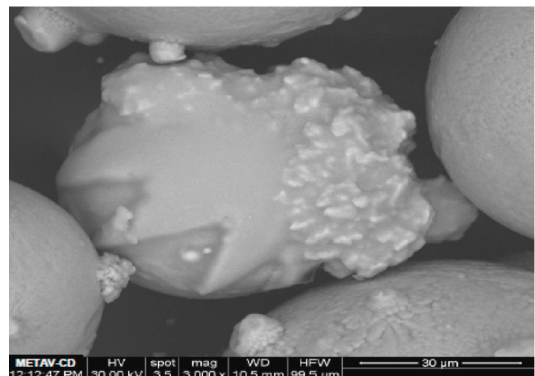
Figure 6. SEM image of the surface morphology revealing the phenomenon of the primarily spheroids and highly